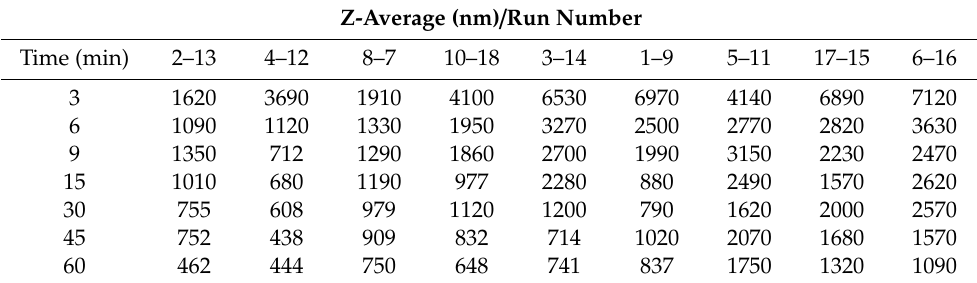
Table 3. Z-Average diameter of IBU during milling with Pharmacoat 603, according to the experimental design.